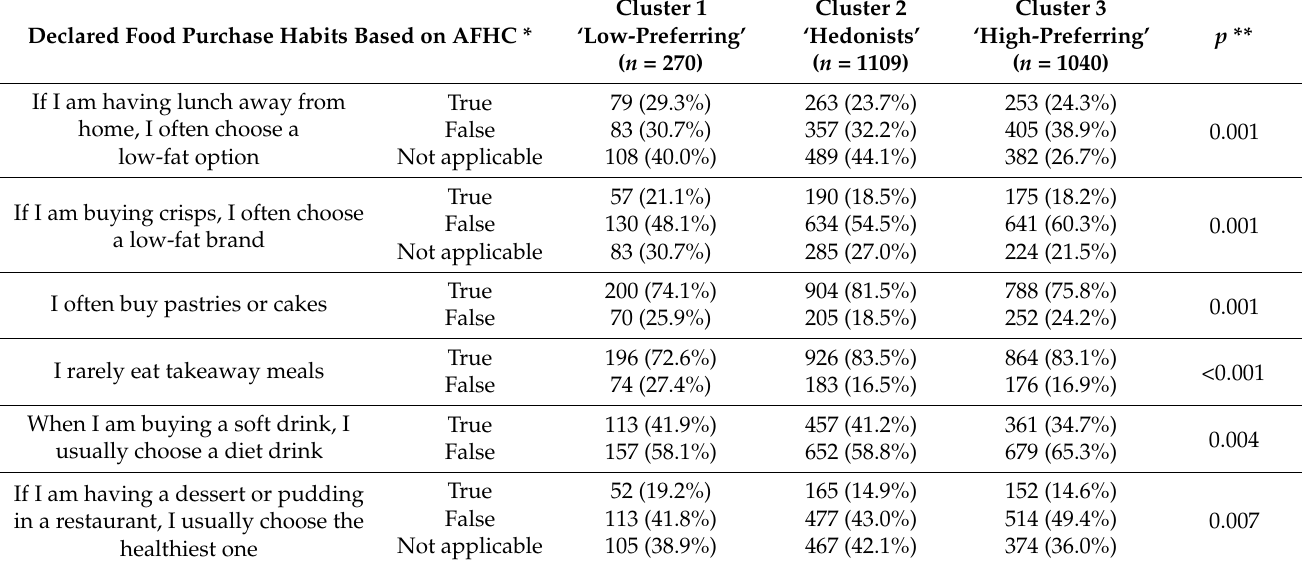
Table 3. The declared food purchase habits assessed based on the Adolescents’ Food Habits Checklist (AFHC) in the clusters stratified based on the preferences assessed while using the Food Preference Questionnaire (FPQ) within the population of the second phase of the Polish Adolescents’ COVID-19 Experience (PLACE-19) Study ( n = 2419).